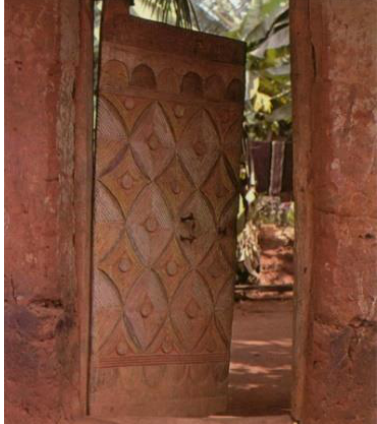
Figure 16 i. Carved Igbo Doors.